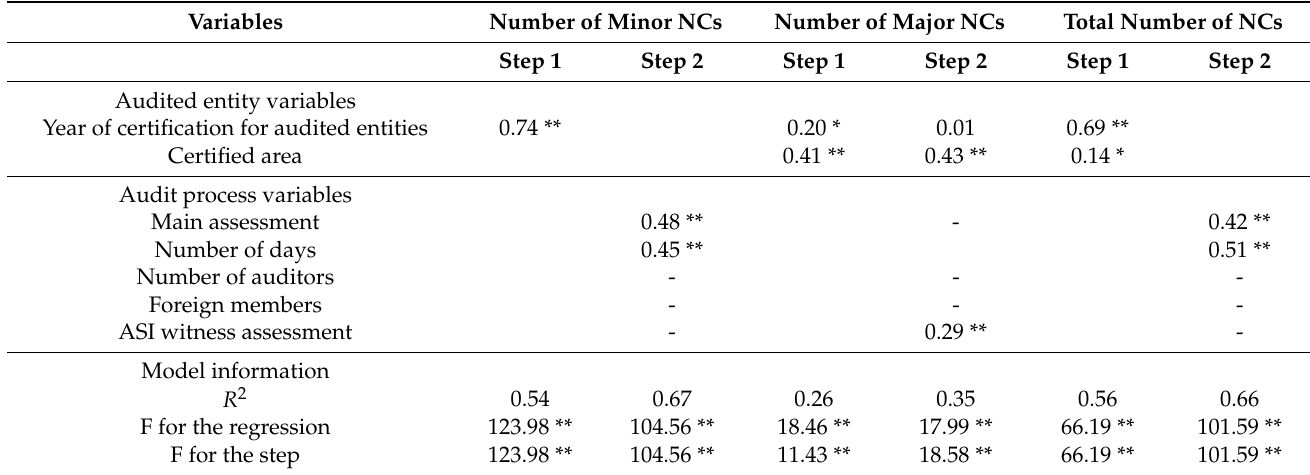
Table 6. Regression analysis of the number of NCs detected in the